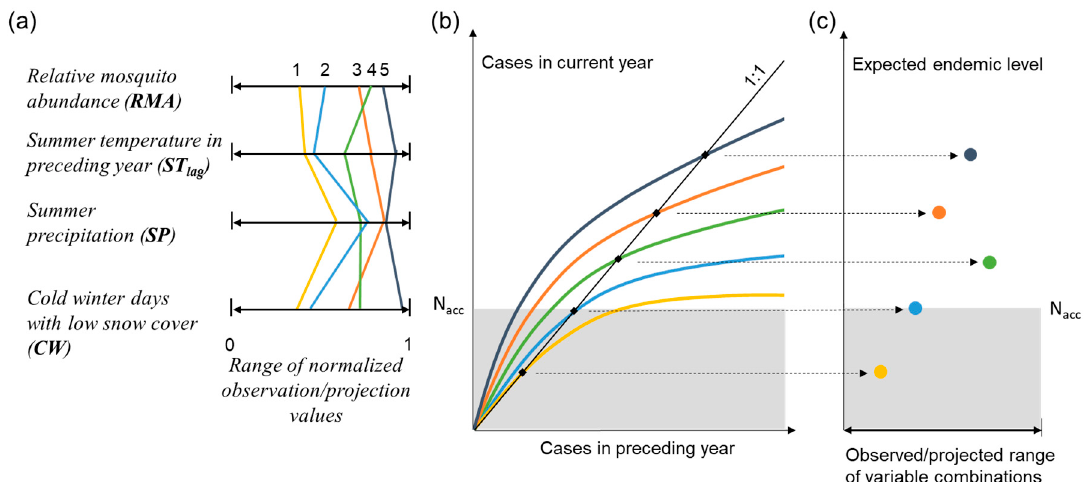
Figure 5. Schematic illustration of how hydroclimatic thresholds to hazardous endemic levels of disease can be identified. The colored curves and symbols show ( a ) examples of hydroclimatic variable value combinations (1–5; di ff erent colored lines) within the respective observed / projected value range of each variable; the di ff erent points that each line passes through in the four normalized axes represent the values of relevant variables in this hydroclimatic setting; ( b ) number of disease cases as a function of number of cases in the preceding year (as explained in Methods, this function can be obtained by substituting values of the four relevant variables from panel (a) into the model), and endemic level (filled black squares) for the hydroclimatic combination examples (1–5, with similarly colored lines as) in panel (a), compared with the maximum societally acceptable endemic level (N acc , upper boundary of gray zone); and ( c ) endemic levels (filled colored circles) for each hydroclimatic combination example (1–5, with similarly colored symbols as the corresponding curves) in panel (a), plotted in relation to the observed / projected variable range (illustrated here for simplicity in just one dimension, the x-axis, whereas the actual range space is multi-dimensional depending on the number of hydroclimatic variables